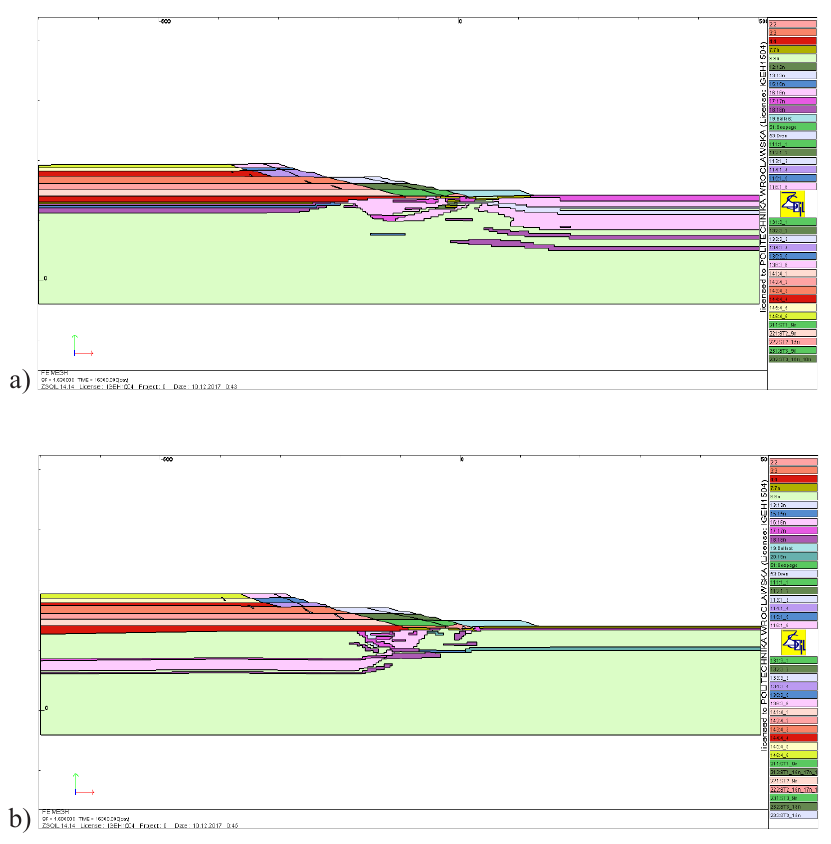
Figure 6: Numerical models of the dam with the substrate: a) cross-section VIIIN and b) cross-section